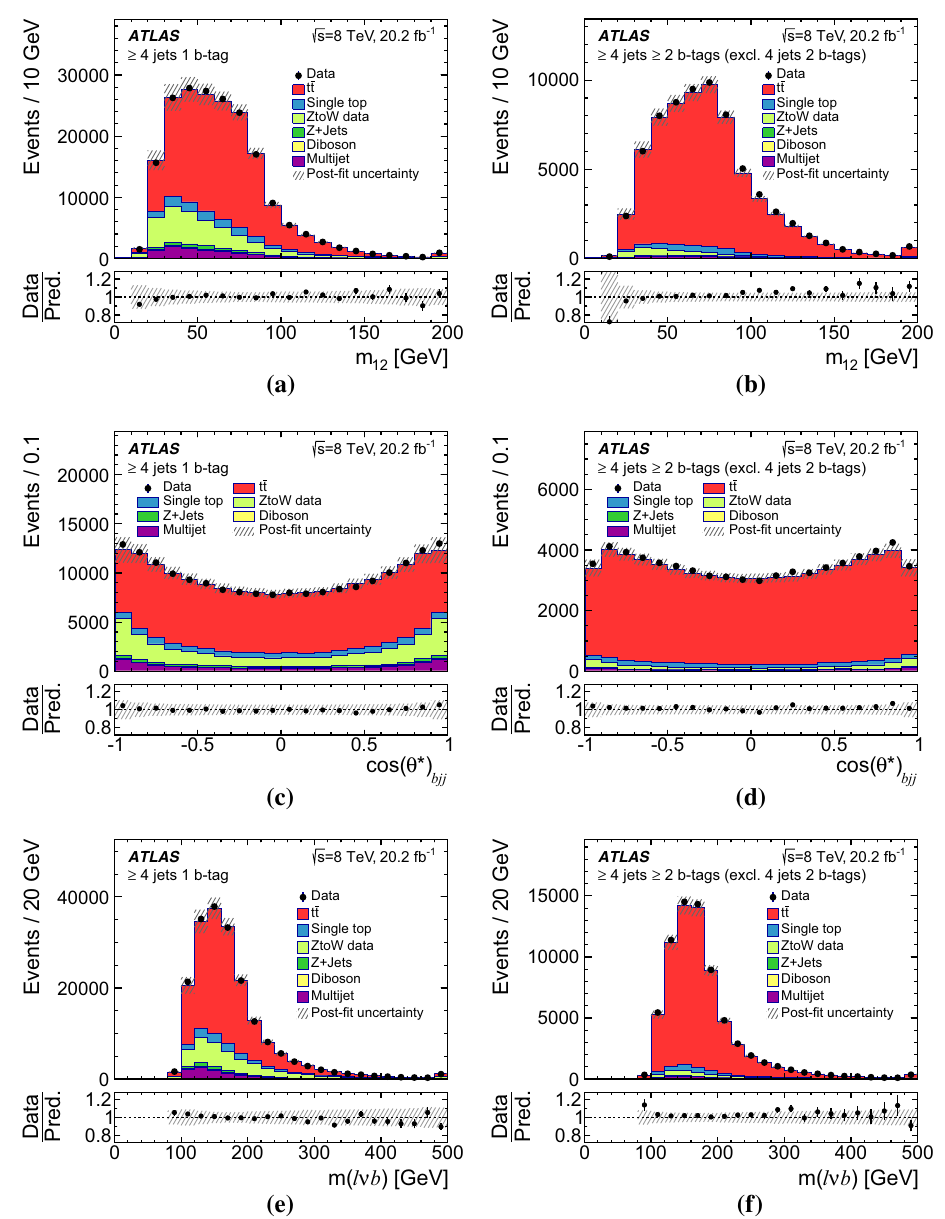
Fig. 7 Distributions of the three most discriminating NN input vari- ables for (left) SR1 and (right) SR3. The signal and backgrounds are normalised to the result of the maximum-likelihood fit: a , b smallest invariant mass between jet pairs, c , d cosine of the angle between the hadronic-top-quark momentum and the beam direction in the t ¯ t rest